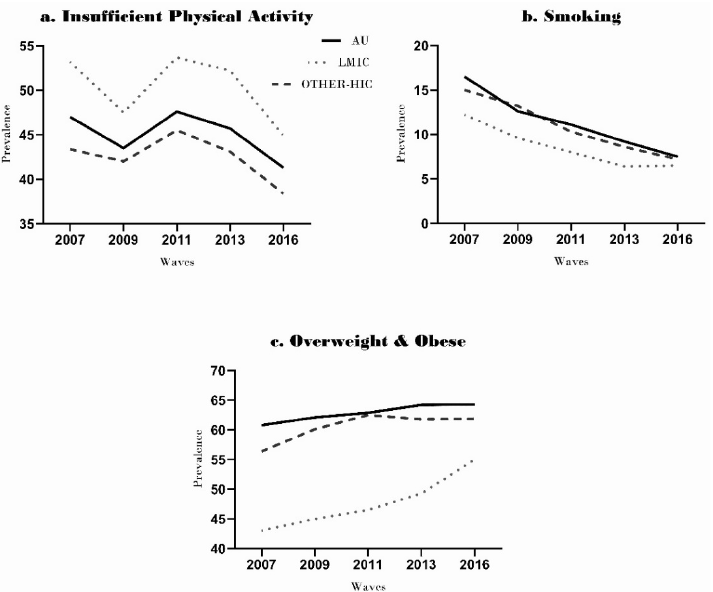
Figure 2. Prevalence of risk factors of immigrants (High-income countries and Low–middle-income countries) and Australian born people across five waves: 2007–2016. ( a ) prevalence of insufficient physical activity across five waves ( b ) prevalence of smoking across five waves ( c ) prevalence of overweight & obese across five waves